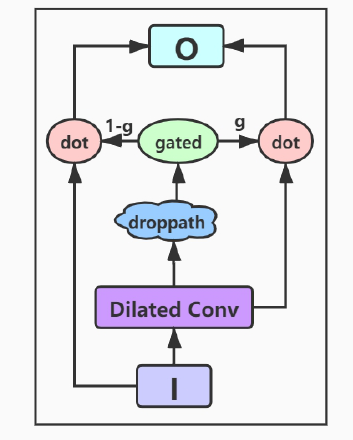
Figure 3. The architecture of Gated Dilated Convolution module.